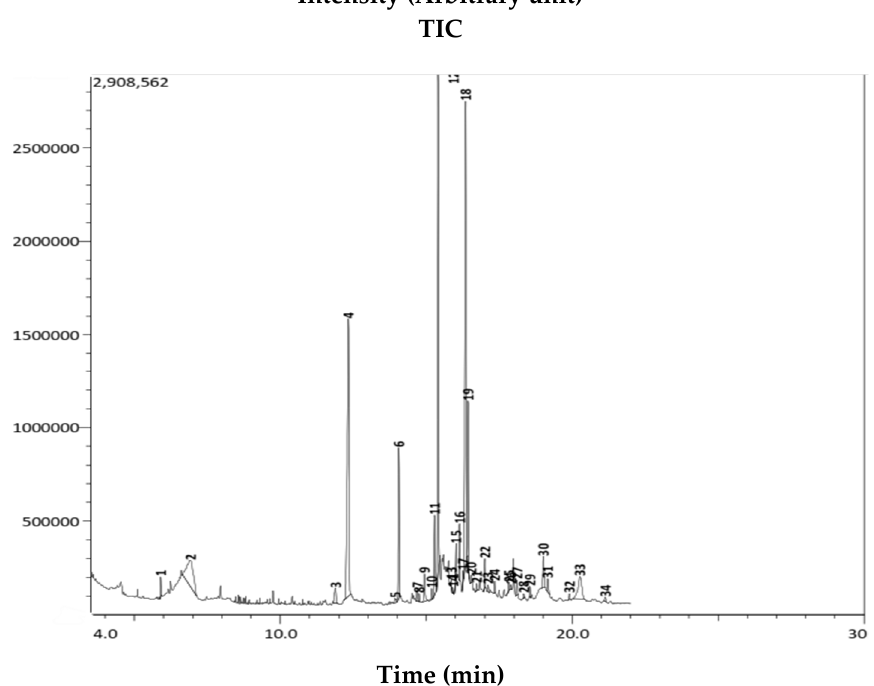
Figure 3. Gas Chromatography-Mass Spectrometry (GC-MS) chromatogram of AWME from BSFL fat. The chemical identity of 34 compounds from AWME fat detected by GC-MS was determined based on NIST Library of chemical compounds.